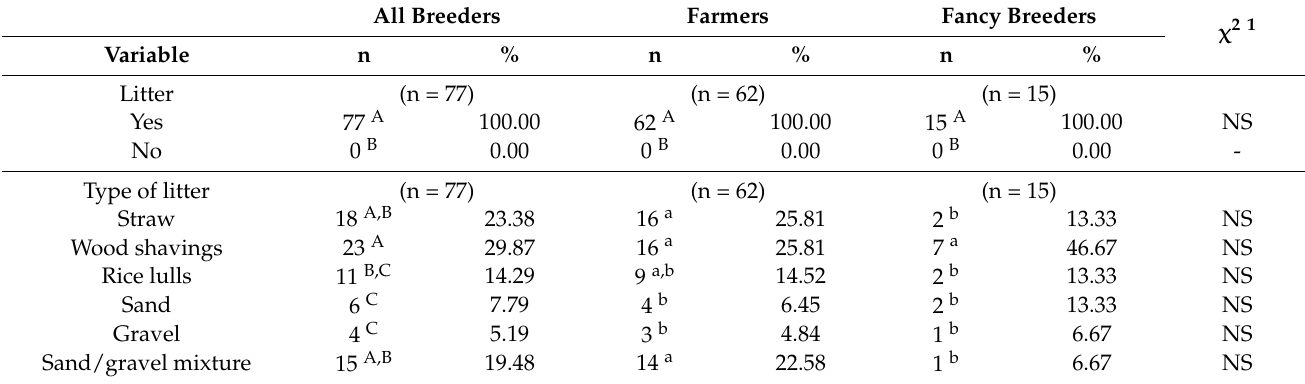
Table 8. Use and type of floor litter: responses from all breeders and divided according to breeder category. All Breeders Farmers Fancy Breeders